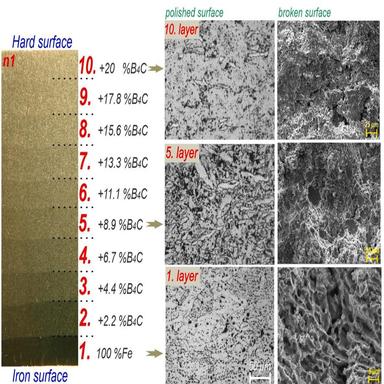
Cross-section of the FGMs along with the magnified micrographs of selected (1st, 5th and 10th) layers before and after fracture.